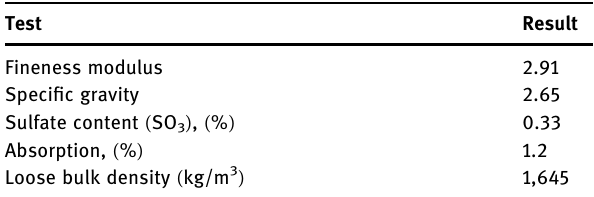
Table 3: Properties of the fi ne aggregate